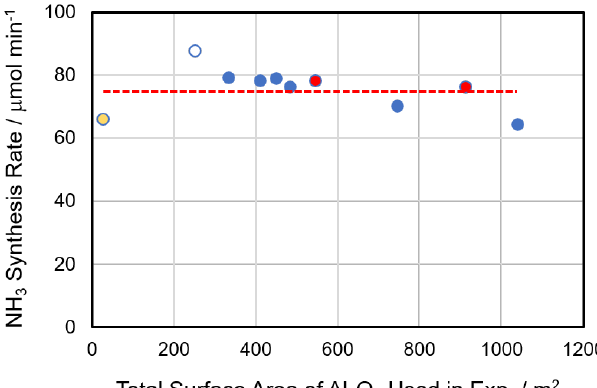
Figure 1. Comparison of activities of various Al 2 O 3 as a function of total surface area and crystal structure. The crystal structure of α , θ , γ , and θ + γ is shown by yellow, white, red, and blue plots. The red broken line is the average NH 3 synthesis rate. Reaction conditions: applied voltage, 6 kV; frequency, 50 kHz; electrode length, 150 mm; total flow rate, 100 mL min −1 ; and H 2 /N 2 = 1.